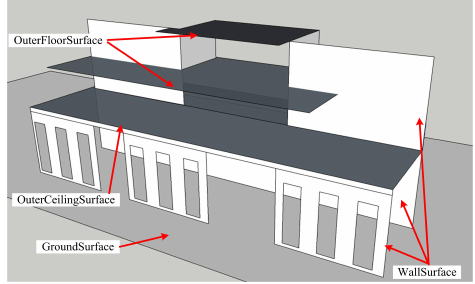
Figure 10. Simplified 3D CityGML model with top-bounded structures